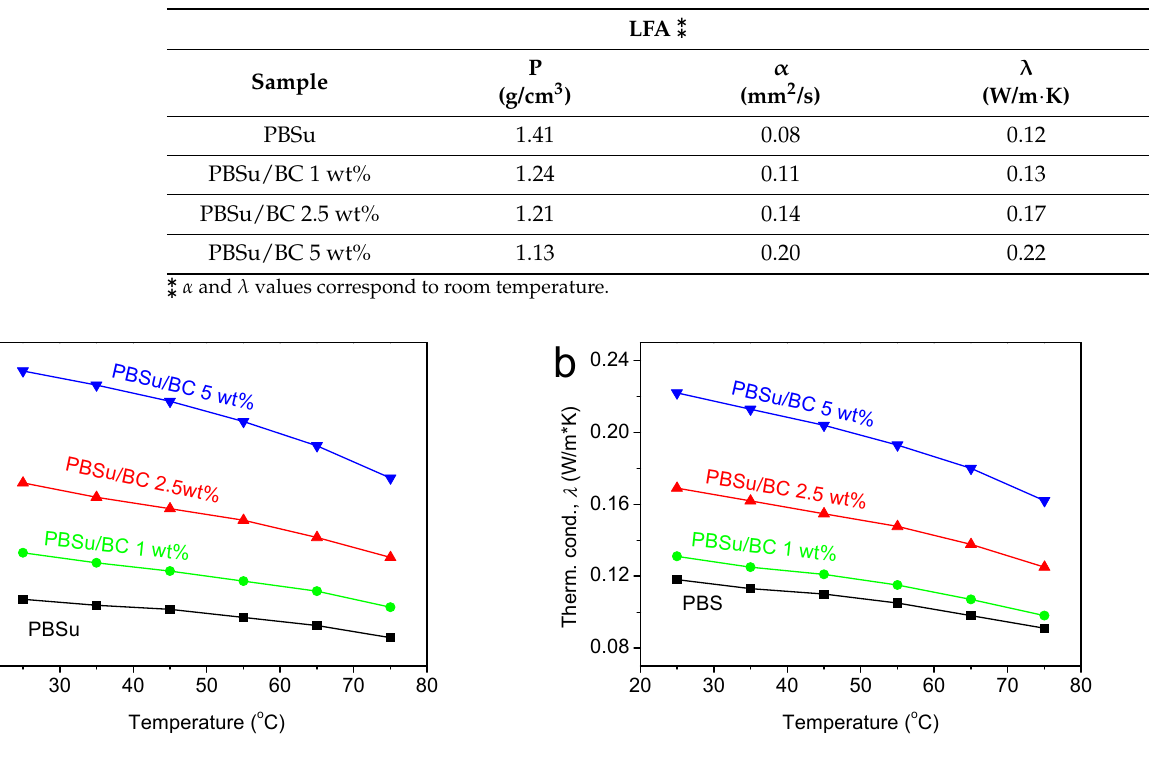
Figure 7. The temperature dependence of ( a ) thermal diffusivity, α , and ( b ) thermal conductivity, λ , for all samples (compositions).